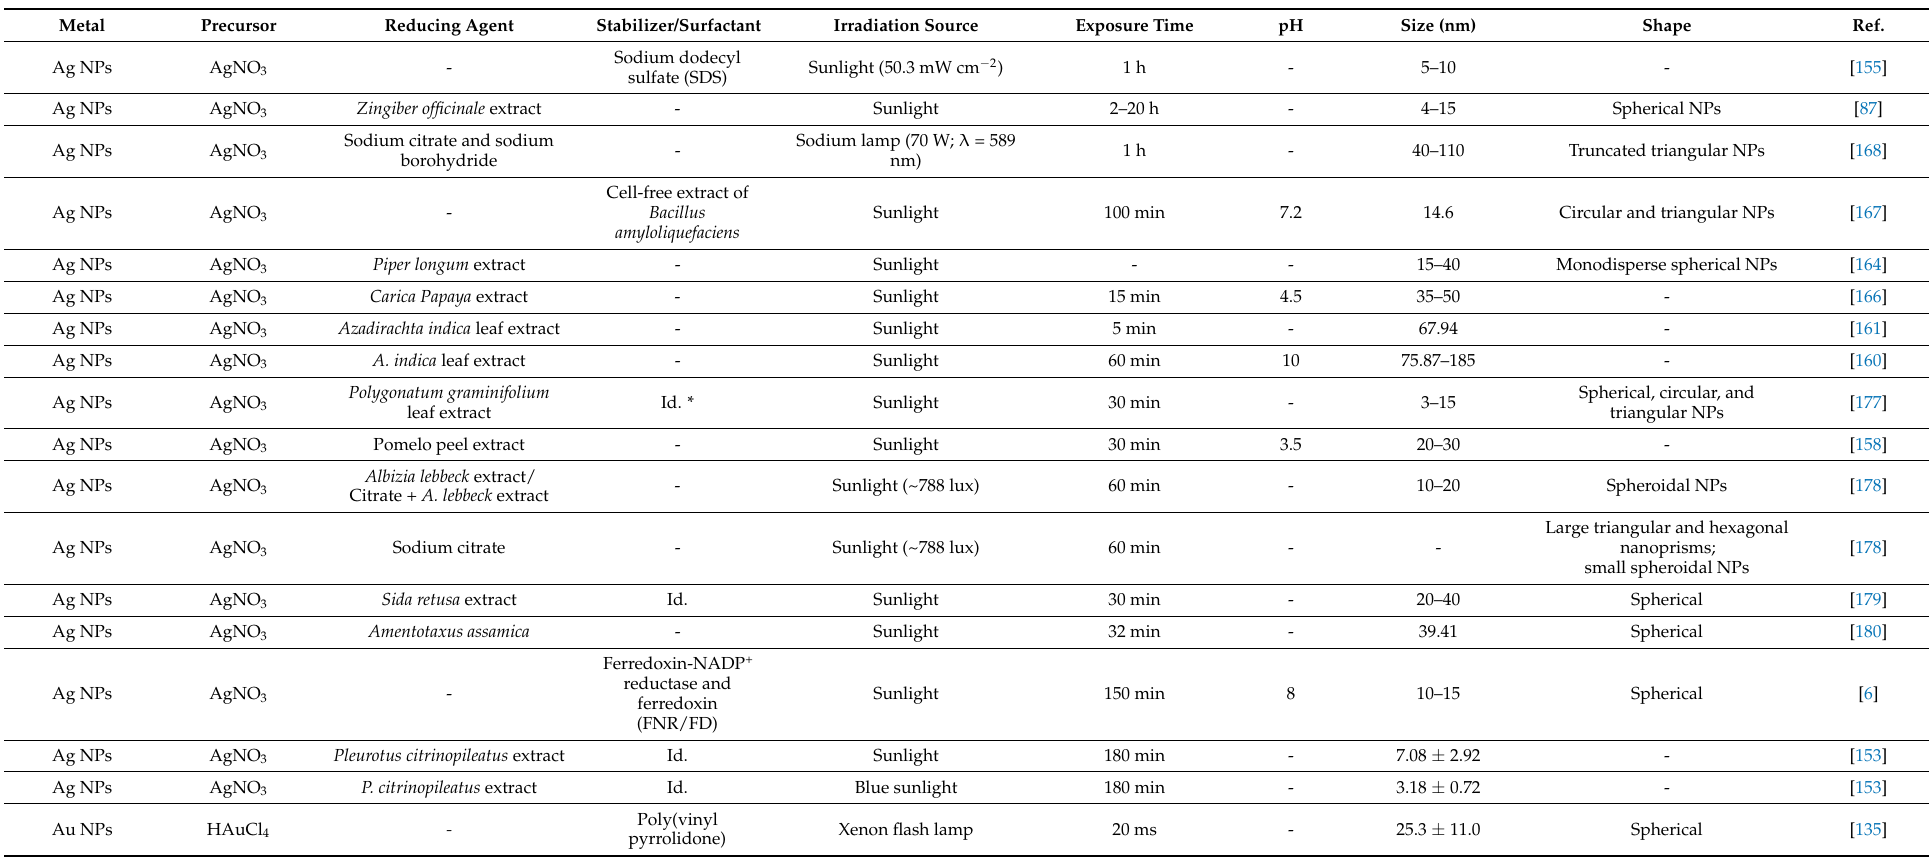
Table 2. Visible light-driven photochemical synthesis of Au NPs and Ag